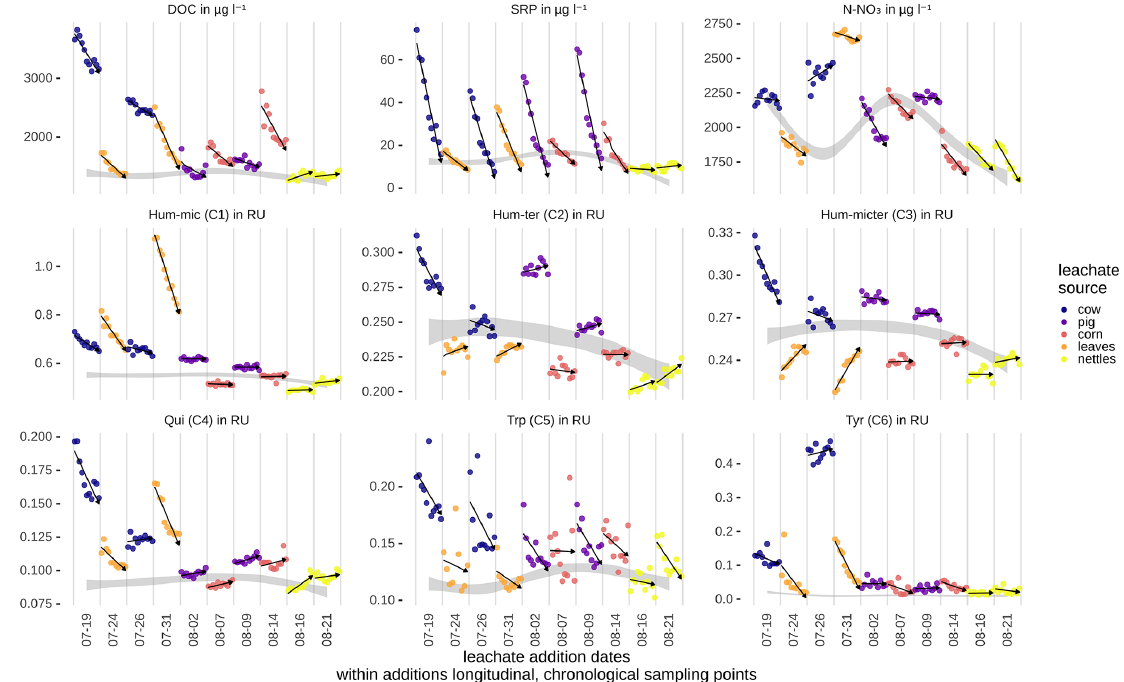
Figure 4. Measured concentrations of DOC, SRP, and N-NO 3 , and Raman units (RUs) of DOM fractions along the stream course for the different samplings. The values are corrected for dilution effects (see also Table S1 in the Supplement). Arrows show the general trend of the concentrations/RUs from up- to downstream. The ambient concentrations were interpolated from measurements taken between leachate additions and are visualized as grey ribbons (see Table S1 for ambient conditions and additional amounts from leachate additions at the upstream station). Table 3. Linear correlation of nutrient concentrations and DOM fraction fluorescence; BFs in brackets; only shown if BF > 1.